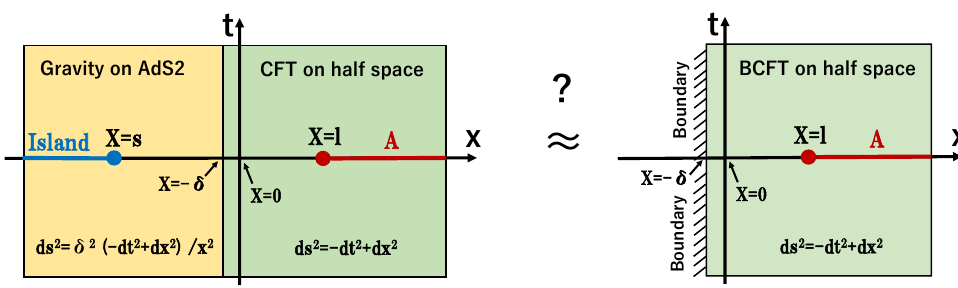
Figure 2 . A sketch of setup of calculating entanglement entropy when we couple a CFT on a half line to a gravity on AdS (left) and an equivalent setup in BCFT 2